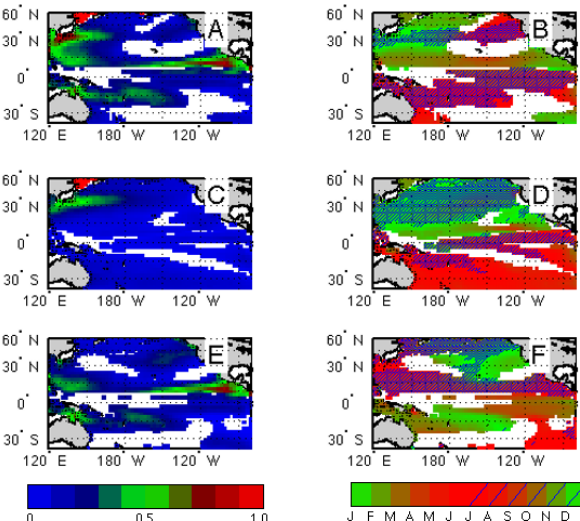
Fig. 7. Amplitude (left column) and phase (right column) of the sea- sonal cycle of (a) and (b) E-P, (c) and (d) evaporation and (e) and (f) precipitation. Panels (e) and (f) present the same information as Adler et al. (2003) Fig. 10. Color scale for panels (a), (c) and (e), is shown below panel (e) with units of 10 − 4 kgm − 2 s − 1 . Color scale for panels (b), (d) and (f) is shown below panel (f). Phase scale in- dicates month of maximum E-P, evaporation or precipitation. Light blue slashes mean maximum SLS occurred during the second half of the year. White or blank areas indicate that enough data existed, but no significant seasonal cycle was found.